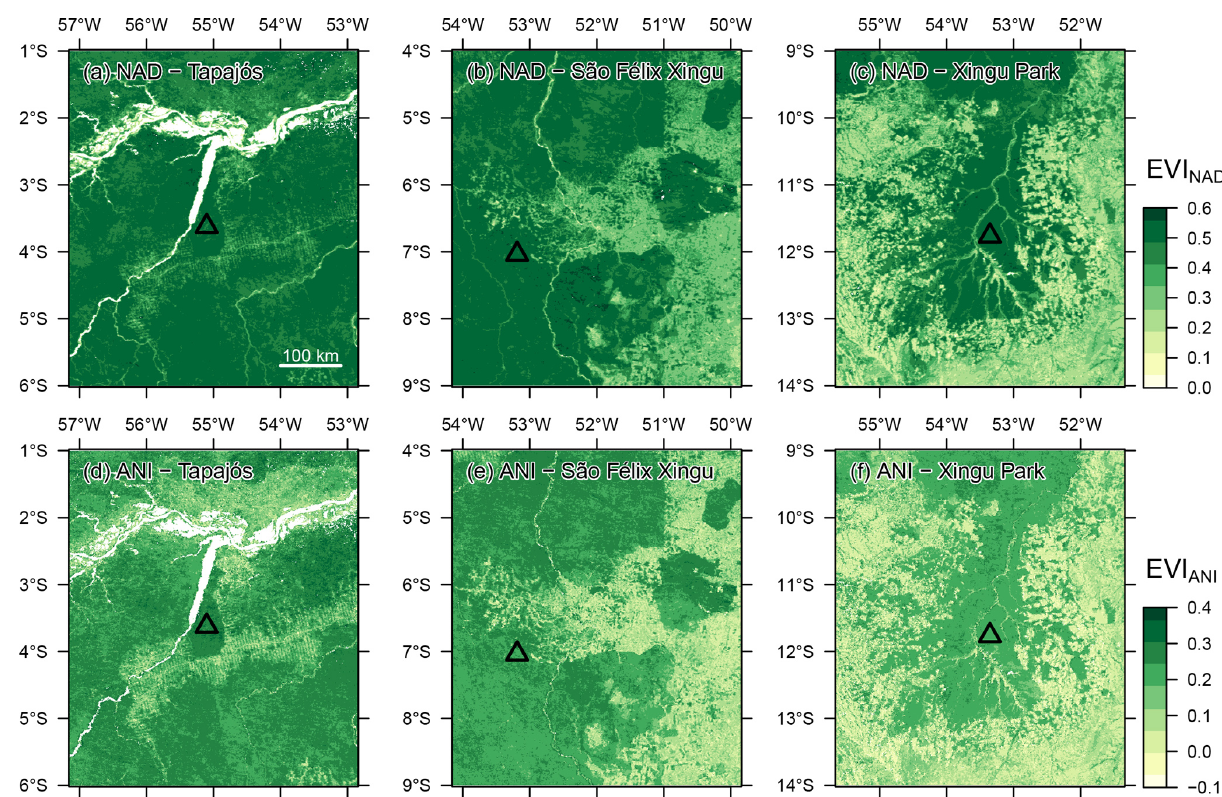
Figure 3. The spatial distribution in August 2020 (dry season) of the nadir-normalized enhanced vegetation index (EVI NAD ) is shown in panels (a) , (b) , and (c) for Tapajós National Forest, São Félix do Xingu, and Xingu Indigenous Park, respectively. The corresponding results for the anisotropy EVI (EVI ANI ) are shown in panels (d) , (e) , and (f) , respectively. The triangles plotted over panels (a–c) indicate the sites used to obtain the profiles in Fig.